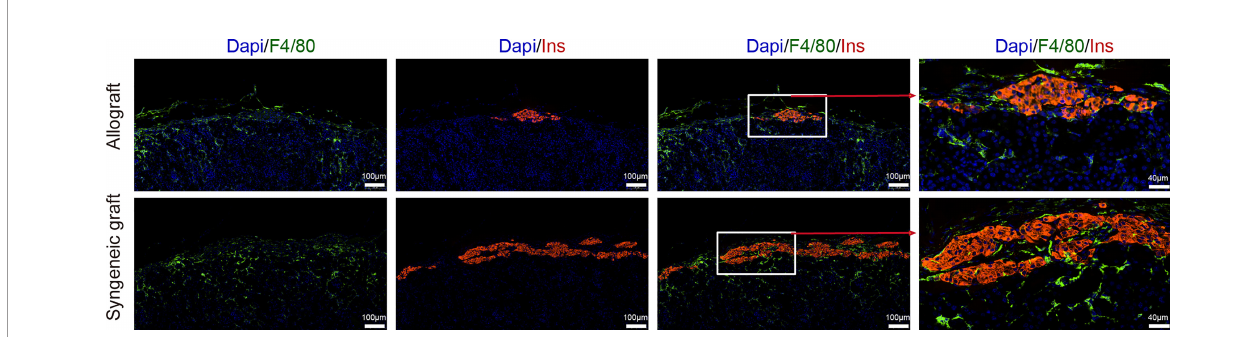
FIGURE 5 | Localization of macrophages in islet grafts. Representative image of a graft section stained with antibodies speci fi c for Insulin (red), F4/80 (green), and DAPI nuclear counterstain (blue). Syngeneic islets graft (C57BL/6 islets to C57BL/6 recipients) and allogeneic islets graft (BALB/c islets to C57BL/6 recipients) were harvested 7 days post-transplantation and sectioned together with